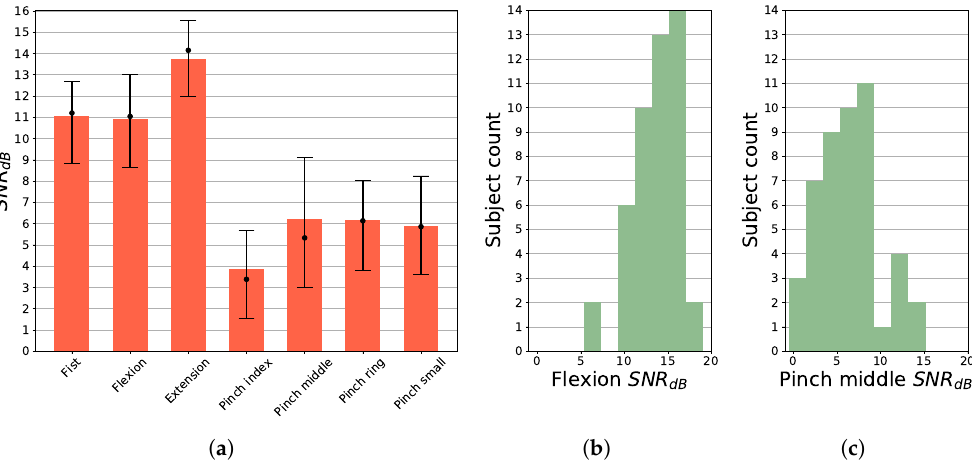
Figure 5. SNR analysis of gesture execution; all values were calculated relative to idle period, in this case considered as noise; for each gesture type SNR was averaged over 5 most active channels; ( a ) SNR by gesture; bars represent mean value; dot marks SNR median value together with 25th and 75th percentile; ( b ) Histogram of SNR for flexion gesture; ( c ) Histogram of SNR for pinch middle